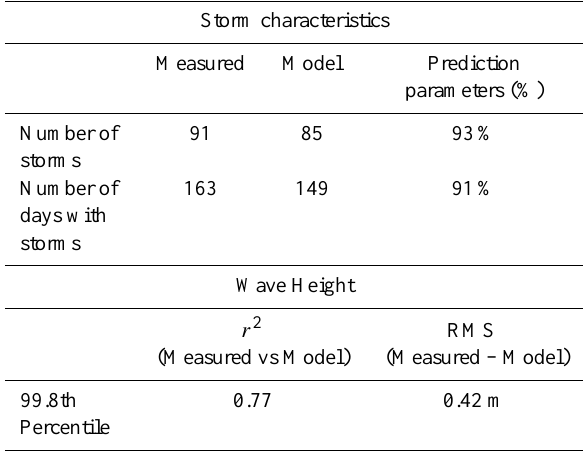
Table 1. Model validation results (1995–2006).